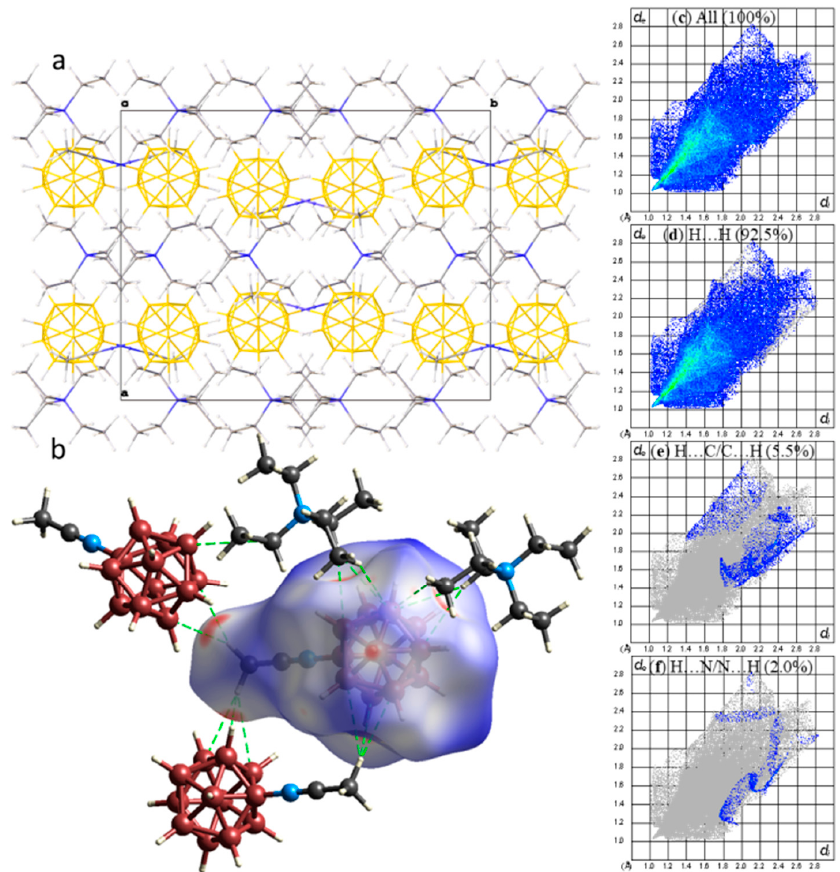
Figure 2. ( a ) Packing diagram, ( b ) d norm surface of ((C 2 H 5 ) 4 N)[B 12 H 11 NCCH 3 ] − anion, ( с ) full two- dimensional fingerprint plot for 1a , together with that delineated into ( d ) H...H, ( e ) H...C/C...H, and ( f ) H...N/N...H contacts. In the packing of compound 1b , the picture is similar to that of compound 1a : the ab plane, which were bonded together, due to weak CH...HB(B) interactions (Figure 3a). The antiparallel [B 12 H 11 NC n -C 3 H 7 ] − anions were similarly bonded by CH...HB(B) contacts between the α -methylene groups of the exo -polyhedral substituent and the boron back- bone of the neighbouring anion (Figure 3b). The Hirshfeld surface fingerprint plot analy- sis shows that the H...H contacts accounted for 88.7% of the anion surface, whereas the H...C/C...H and H...N/N...H contacts accounted for 8.9% and 2.3% of the anion surface, respectively.